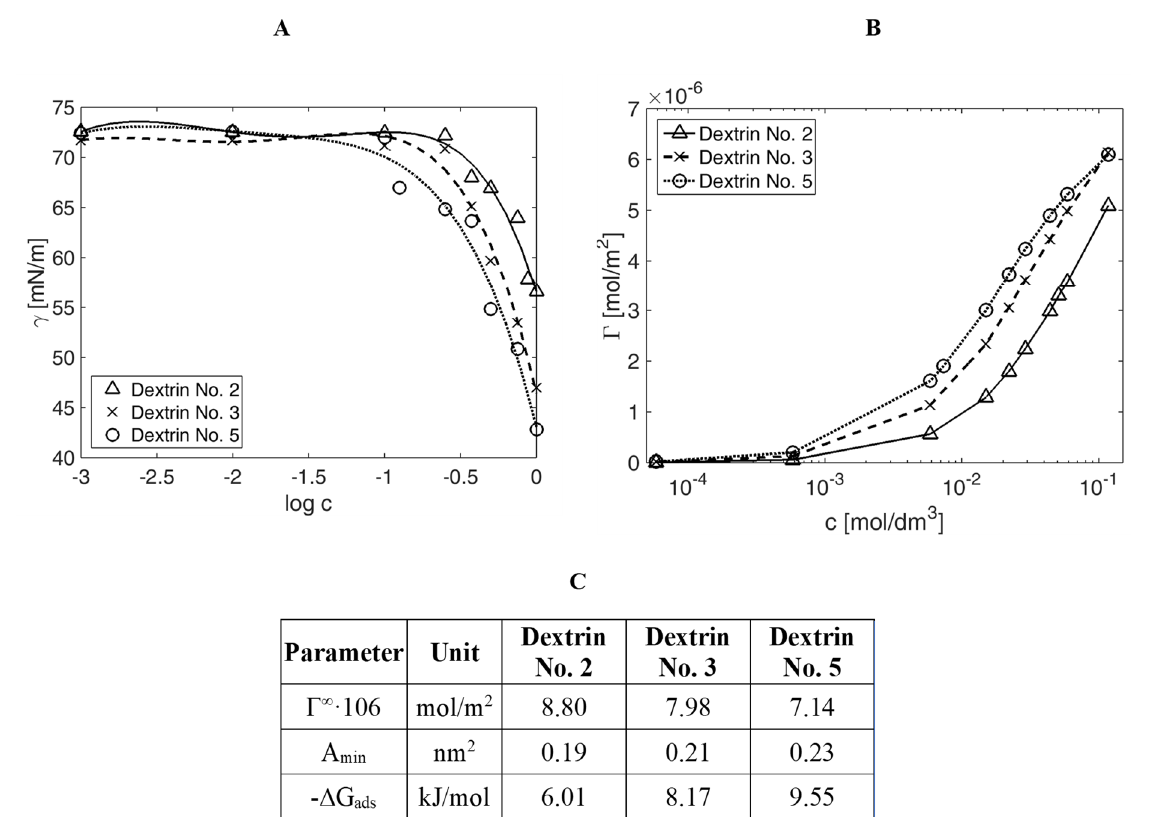
Figure 3. ( A ) The surface tension, ( B ) the excess surface, and ( C ) the adsorption parameters for the aqueous solutions of dextrins in the air/water